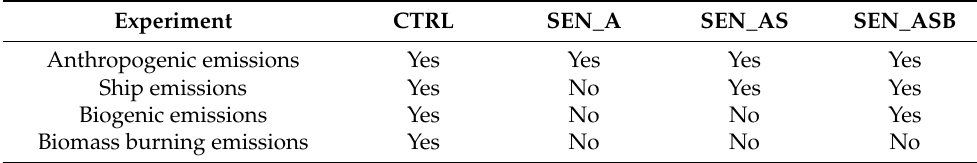
Table 1. Emission settings of different sensitivity experiments using